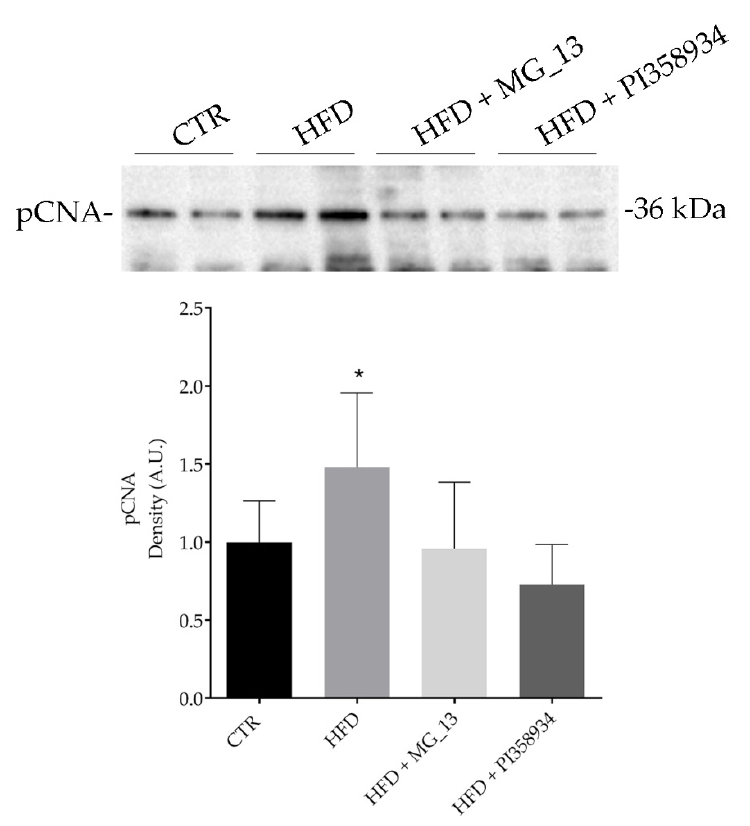
Figure 8. Effects of chickpea diets proliferating cell nuclear antigen (PCNA) expression. Liver lysates were prepared as described in the Methods Section. An equal amount of proteins (30 μ g/lane) was separated by gel electrophoresis and immunoblotted for evaluation of the PCNA levels. Densitometric analysis revealed that the HFD diet (HFD) caused a significant increase in the PCNA levels as compared with mice fed a normal diet (CTR). No significant alterations in PCNA levels were observed in mice fed the HFD + MG_13 diet or HFD + PI358934 diet. Data are expressed as means ± S.D. and analyzed by one-way ANOVA followed by Dunnett’s multiple comparisons test (* p < 0.05 vs. CTR).